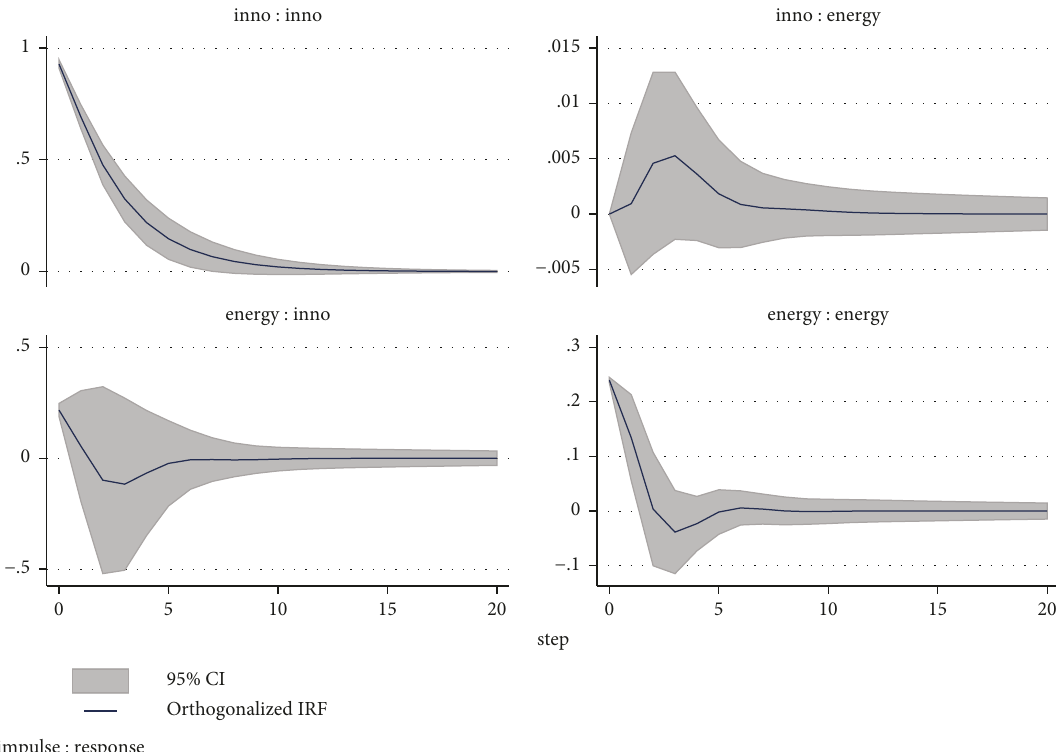
Figure 2: Impulse response. Note: the transverse axis represents the lag period of the impact; the middle curve is the impulse response function curve; and the shadow part is the 95% confidence